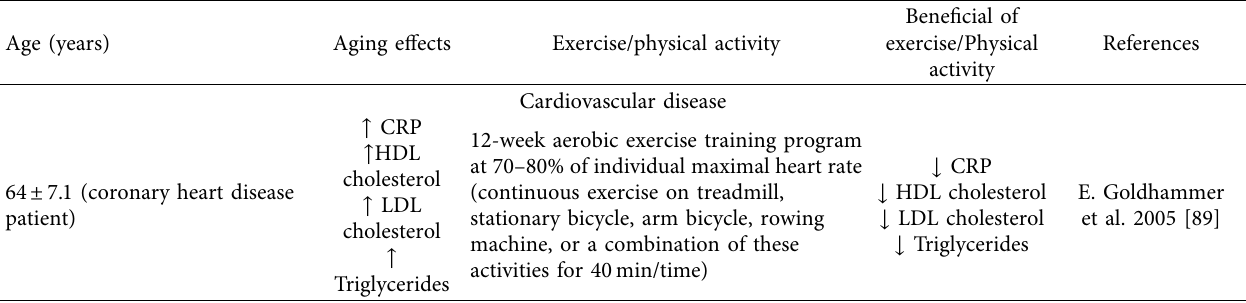
Table 2: Observational studies of the beneficial effects of exercise on cardiovascular disease and hypertension in different age populations. Age